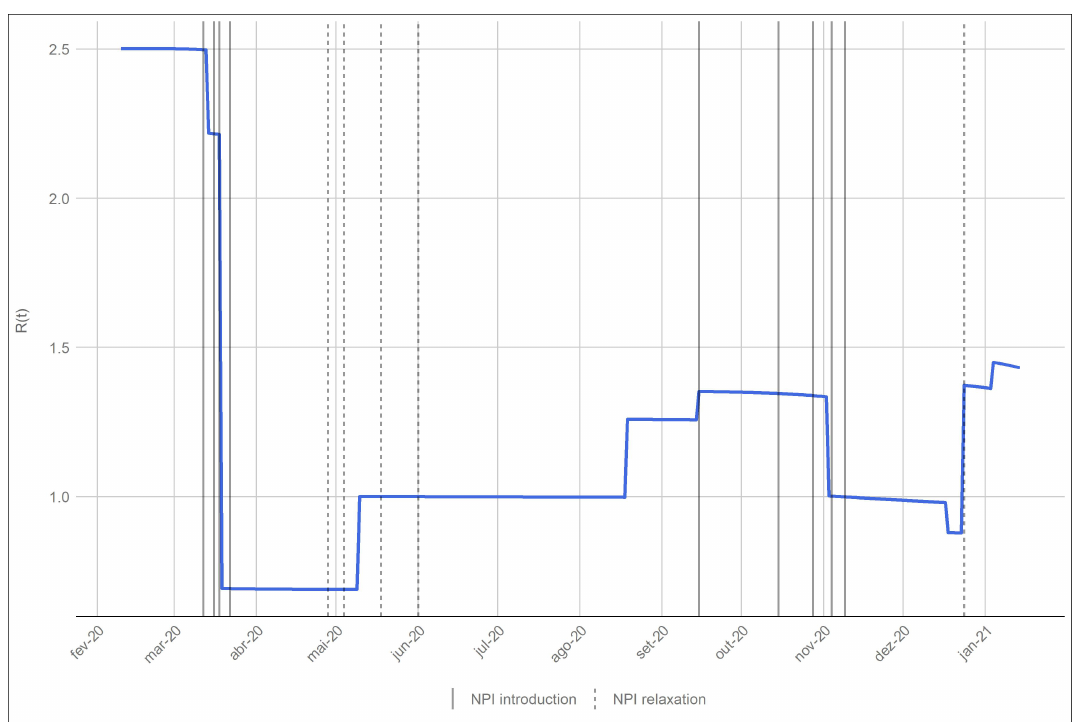
Figure 4. Evolution of the effective reproduction number given by the model. The solid vertical lines correspond to the date of the implementation of a NPI and the dashed lines mark the relaxation of the NPIs in